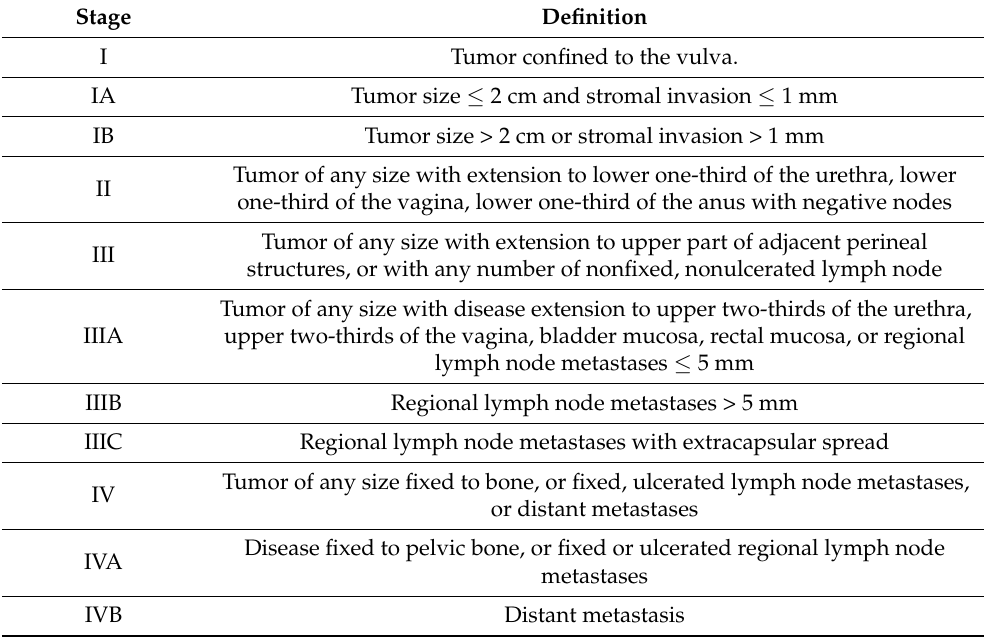
Table 1. FIGO staging for carcinoma of the vulva: 2021 revision. Stage